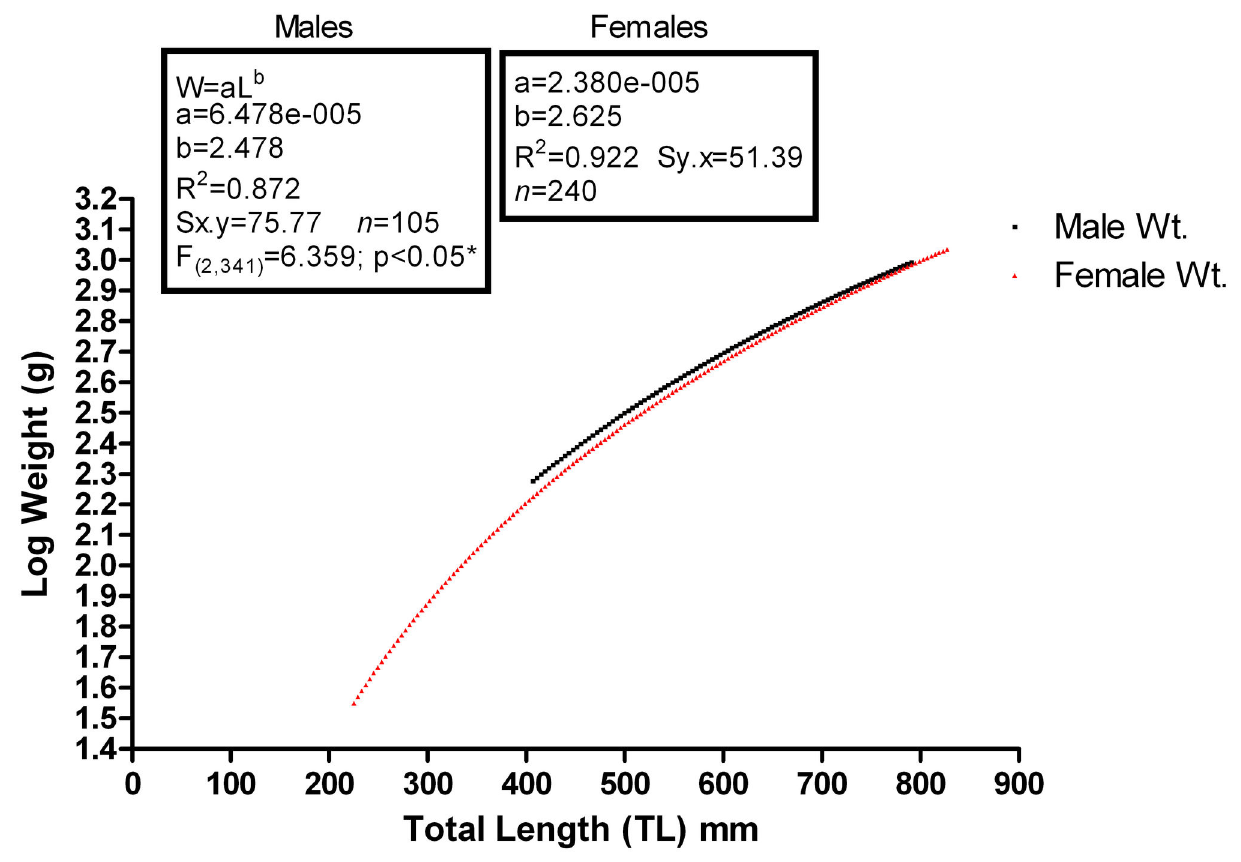
Figure 8. A comparison of male and female L:W curves. The curves are significantly different but parallel, with males heavier than females at all